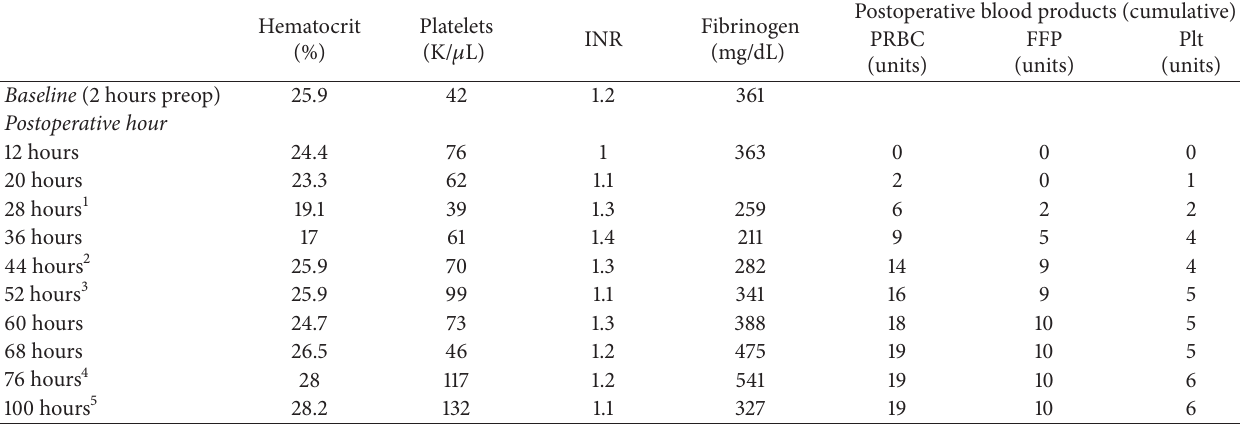
Table 1: Postoperative transfusion requirements and degree of hemorrhage.